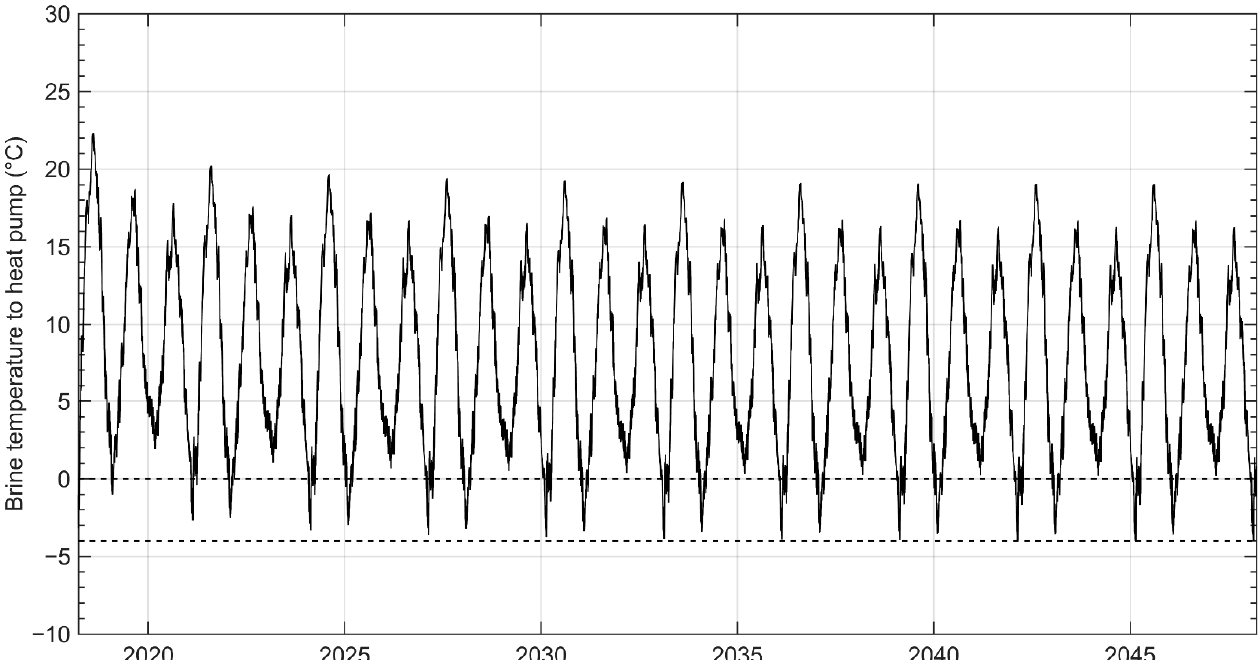
Figure 13. Modelled brine temperatures to the heat pump assuming an annual heat consumption of 30.2 MWh, λ s = 1.50 W/m/K, and u d = 1460 mm/yr.